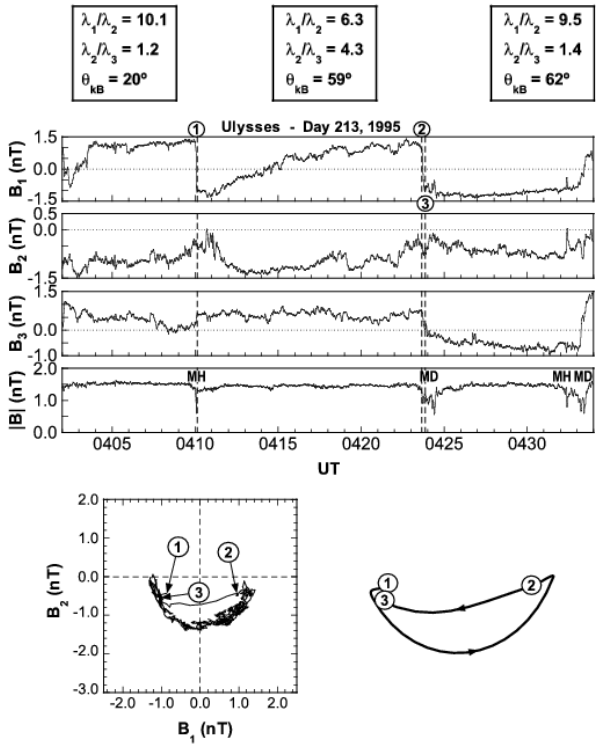
Fig. 3. The relationship between nonlinear Alfv´en waves and MDs. Figure 3 The figure is taken from Tsurutani et al. (2002a). MDs/MHs are Figure 3 present at the phase-steepened edges of the Alfv´en